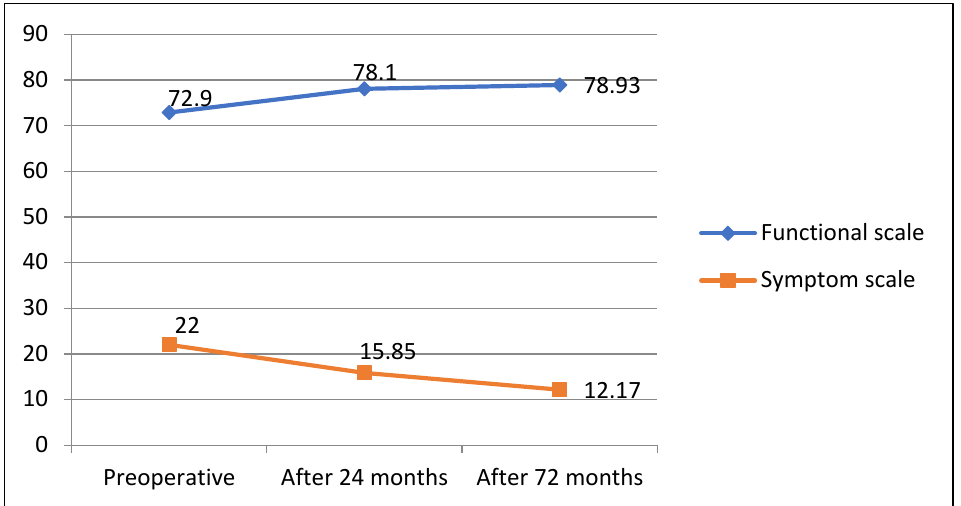
Figure 5. QLQ — CR29 questionnaire outcomes 72 months after surgery. Evaluating the QoL 72 months after surgery between stages of both overall health status and overall QoL scores, we did not find any significant differences ( p = 0.687; p = 0.457) (Figures 6 and 7).